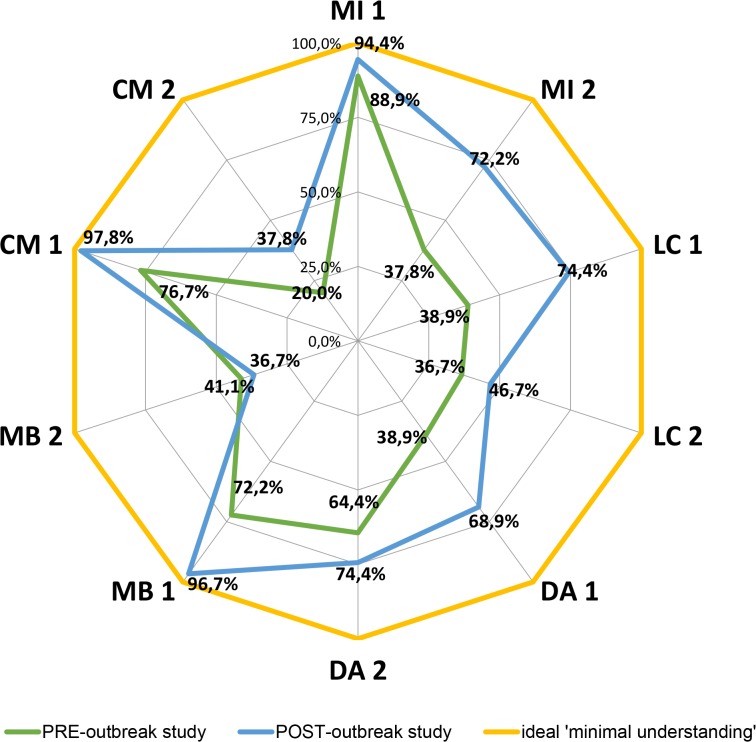
Percentage of residents who have assimilated each Essential concepts in
both PRE-outbreak and POST-outbreak studies.For Figure simplification, essential concepts were abbreviated to their name
initials: Medical Importance 1 and 2 (MI 1 and MI 2), Local Context 1 and 2
(LC 1 and LC 2), Domestic Attribute 1 and 2 (DA 1 and DA 2), Mosquito
Breeding 1 and 2 (MB 1 and MB 2), Control Measures 1 and 2 (CM 1 and
CM2).